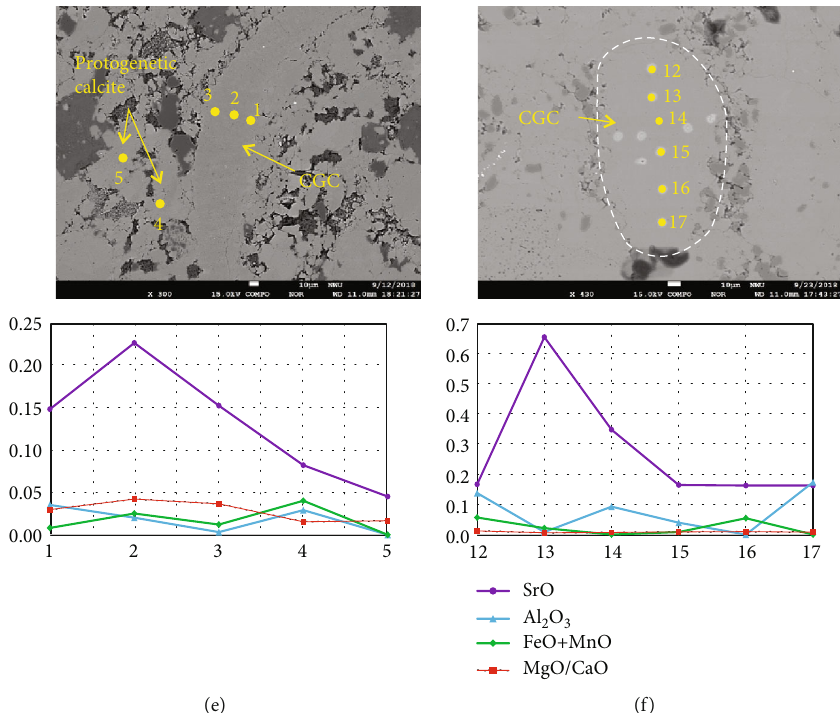
Figure 5: (a) Partially clouded dolomite in the BSE and ERY-3 pro fi les. (b) Mosaic-like dolomite in the BSE and HLCH-89 pro fi les. (c) Cloudy-centered and clear-rimmed dolomite in the BSE and ERY-151 pro fi les. (d) Saddle dolomite in the BSE and HLCH-98 pro fi les. (e) CGC and protogenetic calcite in the BSE and ERY-6 pro fi les. (f) CGC in the BSE and ERY-29 pro fi les. CGC: coarse-grained